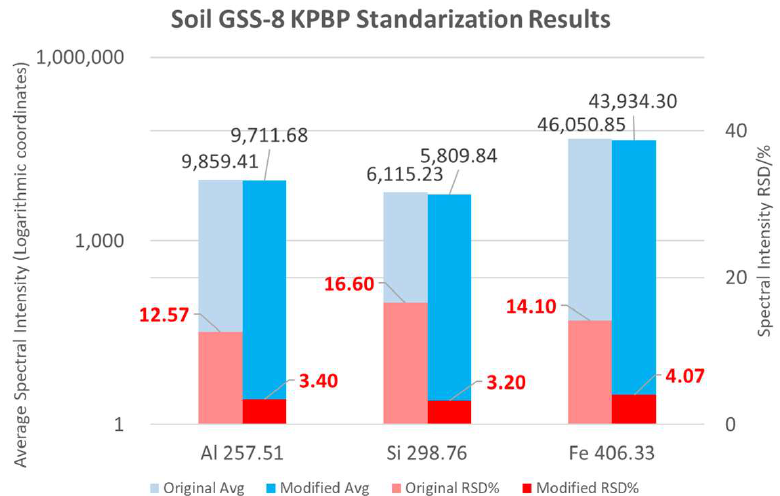
Figure 8. The KPBP standardization results of the GSS-8 soil sample.